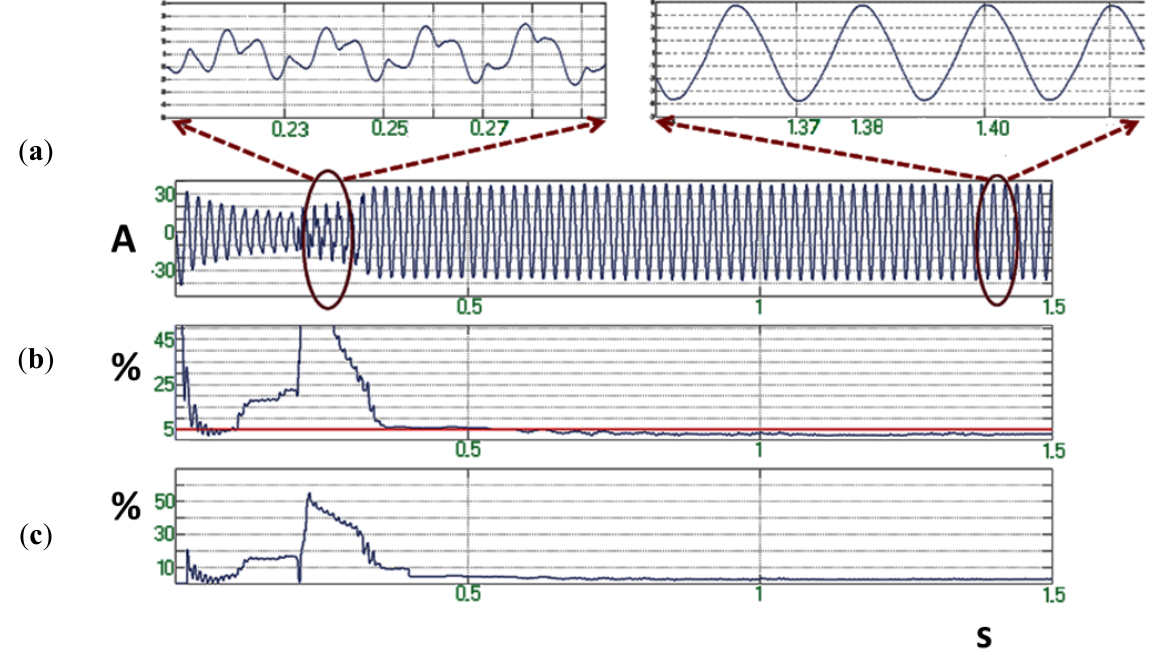
Figure 6. ( a ) Grid’s current 𝐼 ; ( b ) Grid’s current THD; ( c ) Grid’s current 3rd harmonic G component in the second